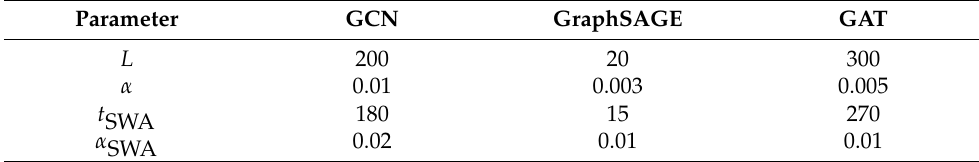
Table A1. The parameter settings for the GNN experiments. The baseline optimizer was Adam with a weight-decay factor of 0.0005. The variable L denotes the total number of epochs, α is the learning rate of the Adam optimizer, α SWA is the constant learning rate used by SWA, and t SWA is the starting point to launch SWA. Parameter